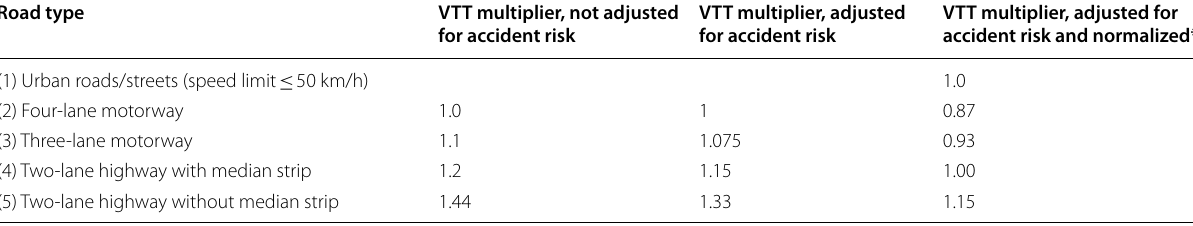
Private travel * Based on the share of traffic on each road type in Norway [11]